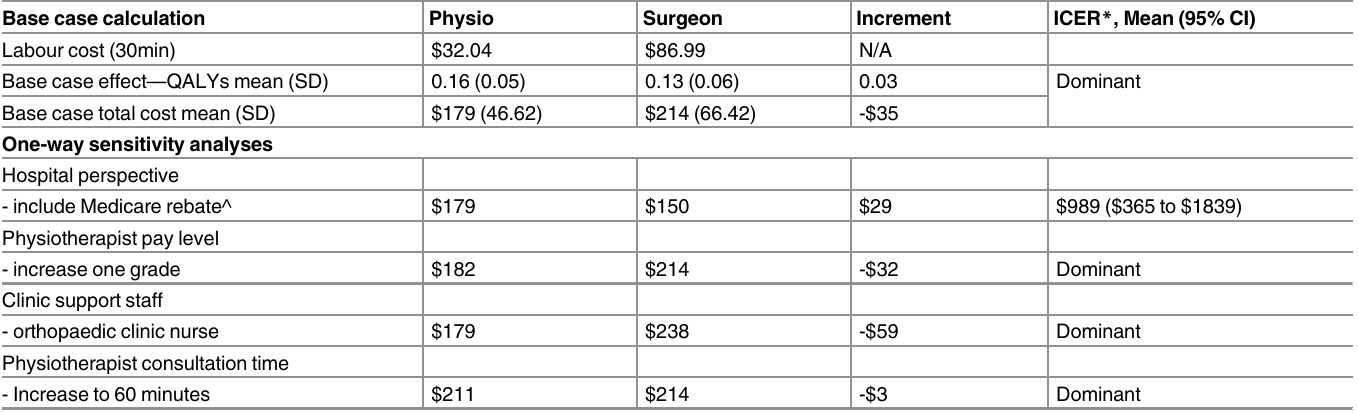
Table 4. Health economic evaluation; base case and one-way sensitivity